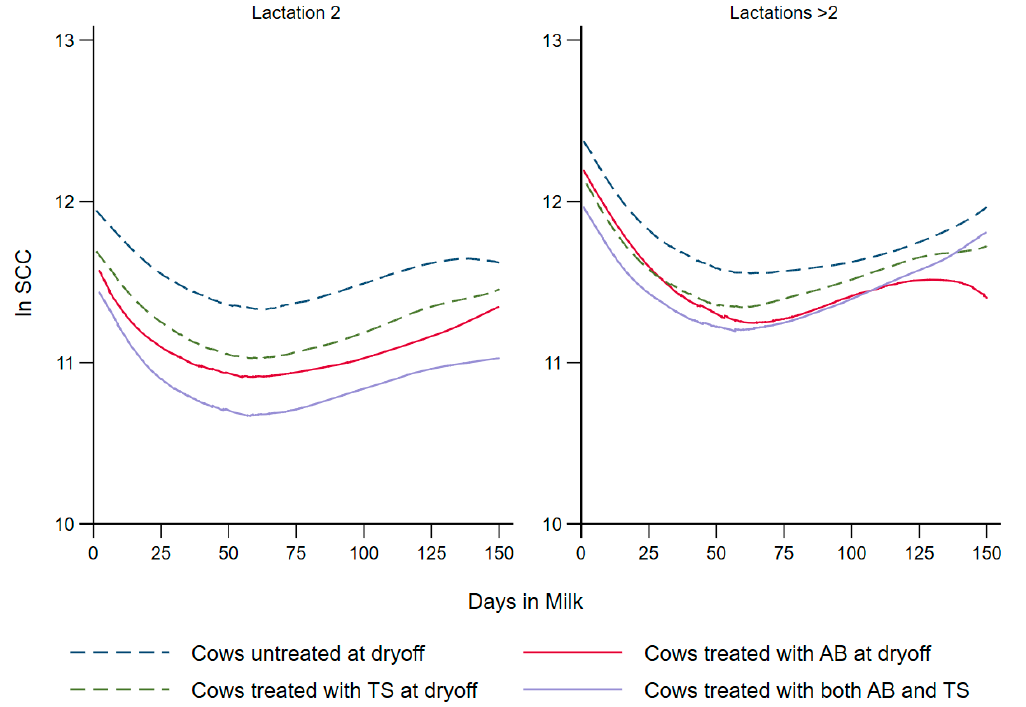
Figure 2. Locally weighted scatterplot smoothing of the predicted natural log of somatic cell count curves for dairy cows that received different dry cow treatments (AB, TS, AB + TS or None). Different dry cow treatments were associated with a significant reduction in the ln SCC during the first 150 DIM following calving. The highest reduction was associated with cows that received both intramammary antibiotics and internal teat sealants, followed by cows that received intramammary antibiotics only, and cows that received internal teat sealant only, in comparison to the untreated cows in the control group. The Bonferroni-adjusted multiple comparisons showed no additional significant differences between the treatment groups. In comparison to the Holsteins, the Jerseys had significantly lower ln SCC, while crossbreeds had a non-significant ( p = 0.08), but numerically lower ln SCC. Cows of third lactation or greater had a significantly higher ln SCC compared to cows in their second lactation. Cows with a teat-end score of four on any teat after calving had a higher ln SCC compared to cows with a teat-end score less than four. Cows with a CMT score of three in any quarter after calving had higher ln SCC compared to cows with a CMT score less than three. Cows with a history of clinical mastitis during the enrollment lactation or any lactation prior to enrollment had significantly higher ln SCC compared to cows with a history of no clinical mastitis. Each additional kilogram of daily milk produced was associated with a decrease in the ln SCC. Model coefficients are on the natural logarithm scale, and hence estimates comparing cows should incorporate the intercept and covariate coefficients relevant to the contrast. The example below compares two Holstein cows with 100,000 SCC/mL 30 days prior to dry-off and not treated with any dry-off therapy. In addition, the first cow completed her first lactation at dry-off, while the second cow completed her second lactation at dry-off with at least one teat-end score of 4, at least one quarter with a CMT score of 3, and a history of mastitis in both previous lactations. Assuming both cows are at 40 DIM in the lactation subsequent to their dry-off with a SCC nadir at 60 DIM, then the estimates based on the SCC model are 119,372 cells/mL and 1024,791 cells/mL for the first and second cows, respectively. To further demonstrate the differences in SCC due to treatment under the same conditions, 40 DIM in the subsequent lactation with a SCC nadir at 60 DIM, had the first cow been treated with AB, her estimated SCC would have been 88,432 cells/mL. Similarly, if the first cow under the same conditions had been treated with TS or AB + TS, her SCC